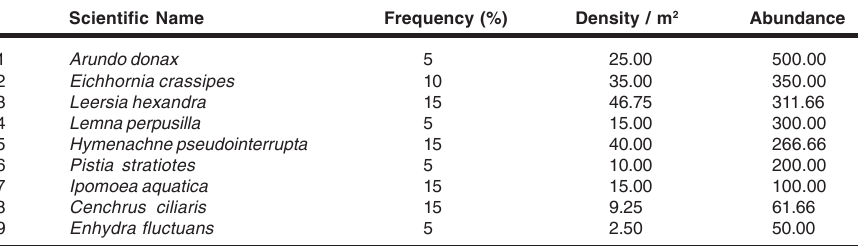
Table 4. Distribution status of aquatic vegetation consumed as food by rhinos in Pobitora Wildlife